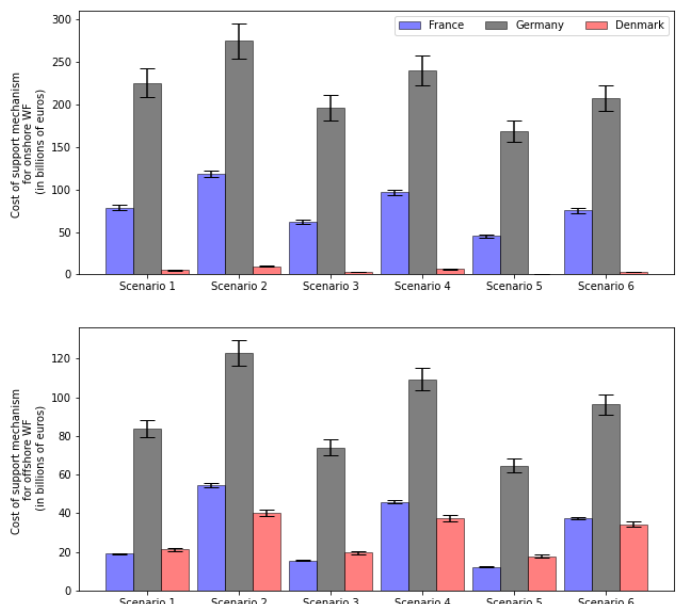
Figure 12. Cost for supporting future onshore ( top panel) and offshore ( bottom panel) wind farm installations for 15 years; profitability (NPV = 0) is guaranteed for 90% of the new wind farms installed. The bars display the mean cost over the 5 models and 2 RCPs used; the uncertainties displayed represent 2 standard deviations. Scenario 1: No demand trends and low wind penetration; Scenario 2: No demand trends and high wind penetration; Scenario 3: Medium demand trends and low wind penetration; Scenario 4: Medium demand trends and high wind penetration; Scenario